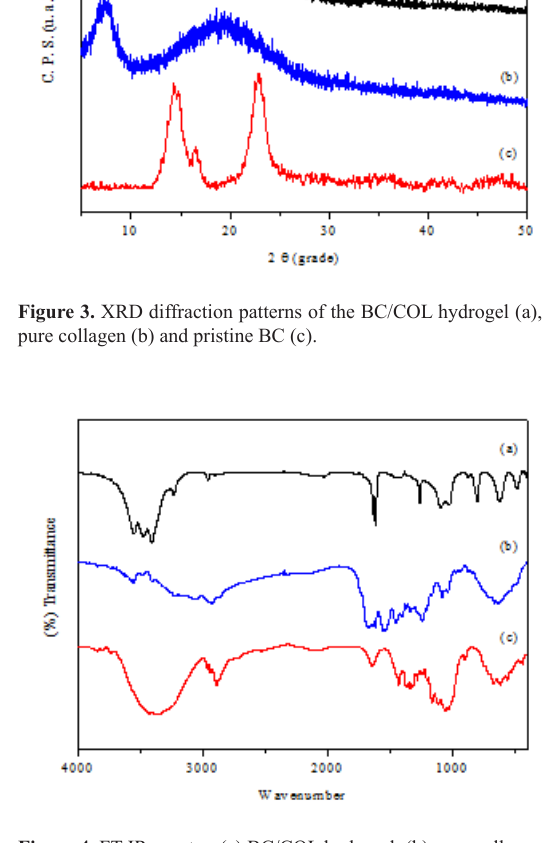
Figure 4. FT-IR spectra: (a) BC/COL hydrogel, (b) pure collagen and (c) pristine